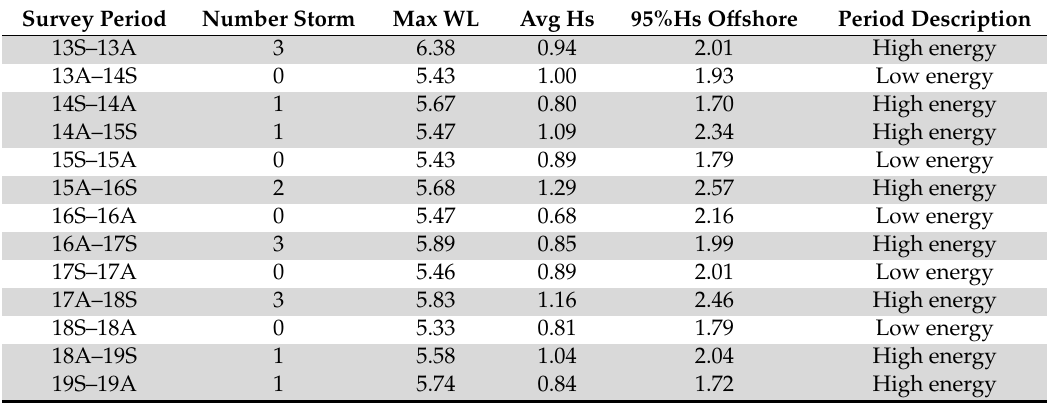
Table 2. Summary of the hydrodynamic conditions over the monitoring period from 2013 to 2019: number of storms exceeding 5.4 m TAW, maximum water level (m TAW), average and 95th percentile of offshore significant wave height (m). A: autumn, S: spring. The survey periods are delimited according to the day of the respective LiDAR surveys. Grey highlights indicate periods of high energetic condition.